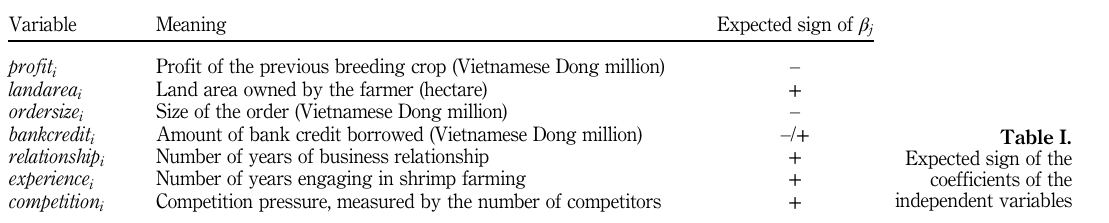
Table I. Expected sign of the coefficients of the independent